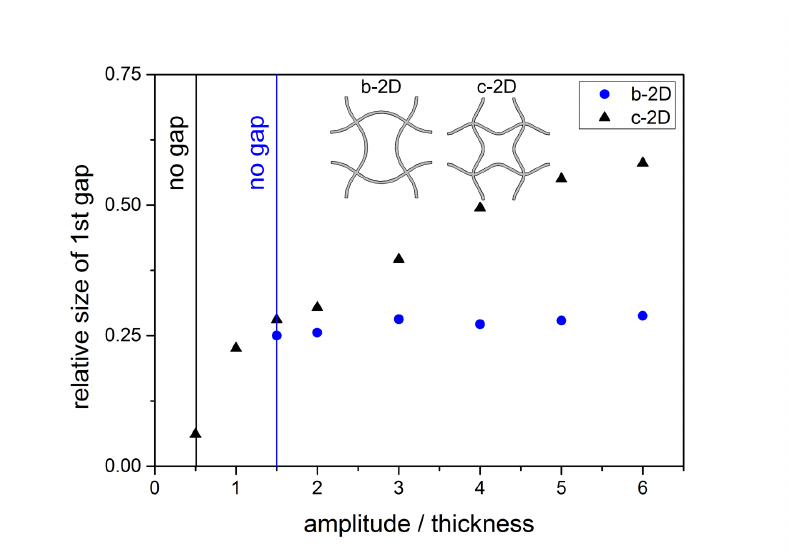
Figure 11. Relative size ∆ ω rel of the 1st band gap for structure b-2D and c-2D in dependancy of the amplitude A of the bent struts (l = 5.0 mm, d = 0.25 mm).